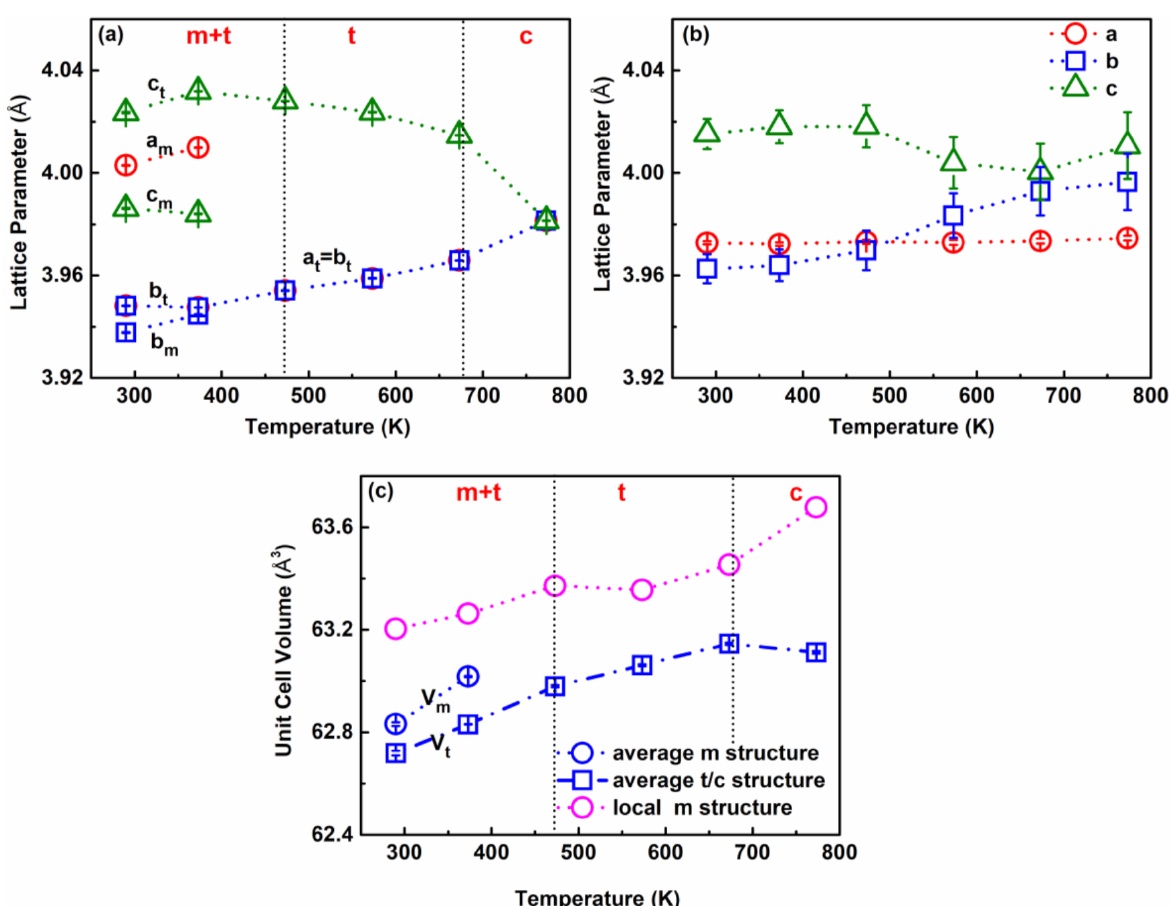
Figure 3. Unit cell parameters for KNNL6 as a function of temperature from 290 to 773 K: ( a ) lattice parameters for the average structure from Rietveld refinement of neutron diffraction patterns. Vertical dotted lines represent phase transition temperatures in the average structure. The letters m, t, and c represent phases of monoclinic, tetragonal, and cubic, respectively. ( b ) Lattice parameters for the local structure from fits to G ( r ) of r~1.7–10 Å. ( c ) Unit cell volume for the average and local structure of KNNL6. Note that blue symbols represent parameters obtained from average Rietveld refinement, while the pink symbols represent parameters obtained from PDF refinement in the r range of 1.7–10